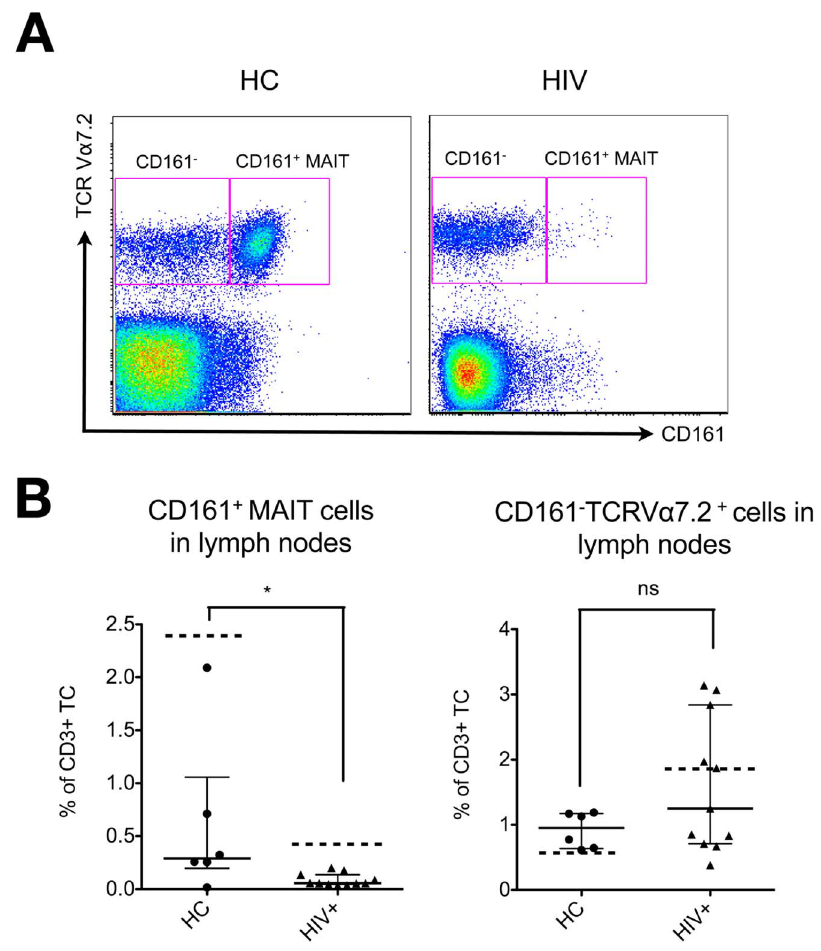
Figure 2. The frequency of CD161 + MAIT cells is severely reduced in lymph nodes of HIV-infected patients. A ) Gating strategy for the characterization of MAIT cells and CD161 - TCRV a 7.2 + cells within the CD4 – T cell subset of lymph node mononuclear cells (LNMC). Representative FACS plots for LNMC from a healthy control and an HIV-infected patient are shown. B ) Frequencies of CD161 + MAIT cells and CD161 – TCRV a 7.2 + cells as percentages among CD3 + lymphocytes for LNMC samples derived from healthy controls (healthy, n=6) and HIV-infected patients (HIV, n=11). Bars and lines indicate median and interquartile range. Dotted lines indicate the frequencies in the PBMC compartment of unmatched but similar groups for comparison. P-values are results of unpaired Mann-Whitney tests.